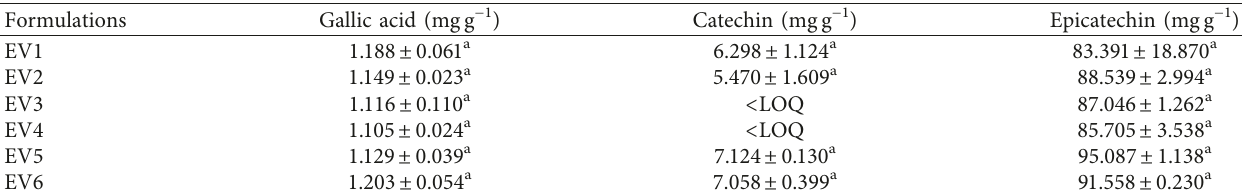
Table 7: Identification and quantification of the phenolic compounds in different powdered antioxidant formulations by UHPLC. Formulations